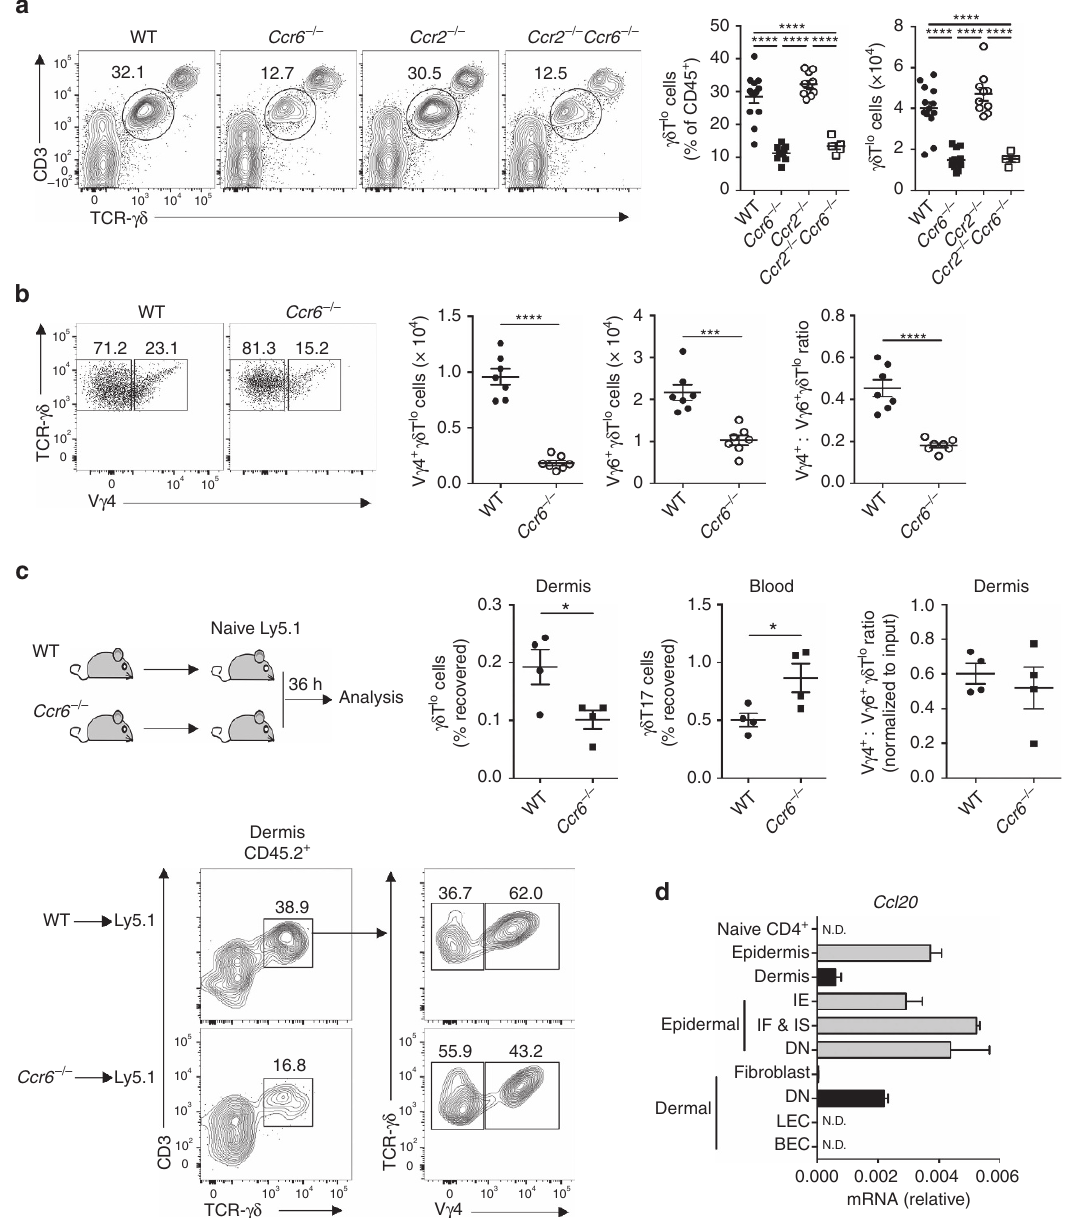
Figure 4 | CCR6 regulates homeostatic cd T17 cell recruitment to dermis. ( a ) Representative flow cytometry and quantitation of CD45 þ CD3 lo TCR- gd lo ( gd T lo ) cells from ear skin dermis of naı¨ve wild type (WT) ( n ¼ 13), Ccr6 (cid:2) / (cid:2) ( n ¼ 11), Ccr2 (cid:2) / (cid:2) ( n ¼ 10) and Ccr2 (cid:2) / (cid:2) Ccr6 (cid:2) / (cid:2) mice ( n ¼ 5). ( b ) Representative flow cytometry of V g 4 expression by dermal gd T lo cells and quantitation of V g 4 þ and V g 4 (cid:2) gd T lo cells in dermis of WTand Ccr6 (cid:2) / (cid:2) mice ( n ¼ 7/group). ( c ) WT or Ccr6 (cid:2) / (cid:2) lymphocytes were transferred i.v. into naı¨ve Ly5.1 mice ( n ¼ 4/group). After 36h, number of CD45.2 þ gd T lo / gd T17 cells recovered was expressed as % of number transferred. Representative flow cytometry of dermal CD45.2 þ cells and quantitation of gd T17 cell recovery and V g 4 þ :V g 4 (cid:2) ratio (normalized to input). ( d ) Ccl20 mRNA from whole tissues or sorted CD45 (cid:2) epidermal keratinoctyes (Sca-1 þ Ep-CAM lo interfollicular epidermis (IE), Sca-1 lo/ þ Ep-CAM þ infundibulum and isthmus (IF & IS), Sca-1 lo Ep-CAM lo double negative (DN)) or CD45 (cid:2) dermal populations (CD31 (cid:2) CD90 þ CD140 a þ fibroblast, gp38 þ CD31 þ lymphatic endothelial cells (LEC), gp38 lo CD31 þ blood endothelial cells (BEC), CD31 (cid:2) CD90 (cid:2) CD140 a (cid:2) double negative (DN)) from naı¨ve WTmice (pooled from 5 mice/experiment). ND, not detected. See also Supplementary Fig. 5. Mean ± s.e.m. ( a , d ) Pooled from three experiments, ( c ) representative of two similar experiments. ( a ) One-way ANOVA with Bonferroni’s multiple comparisons test, ( b , c ) unpaired two-tailed Student’s t -test. * P o 0.05, ** P o 0.01, *** P o 0.001, **** P o 0.0001.